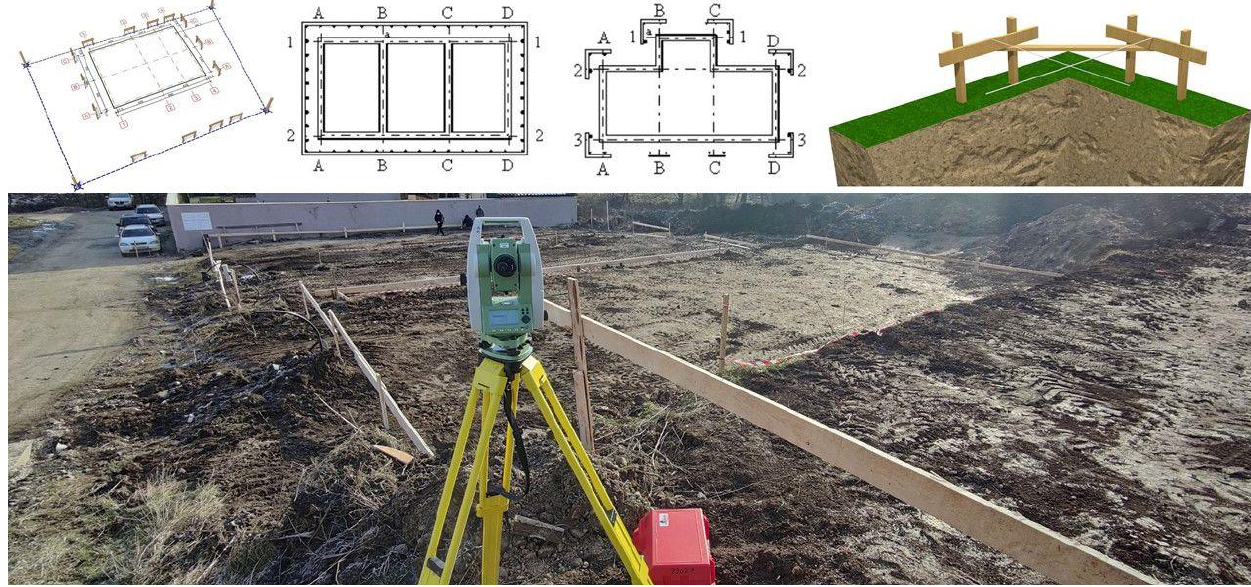
Figure 6. Examples of batter boards ( top ); the present in-site conditions ( bottom ).